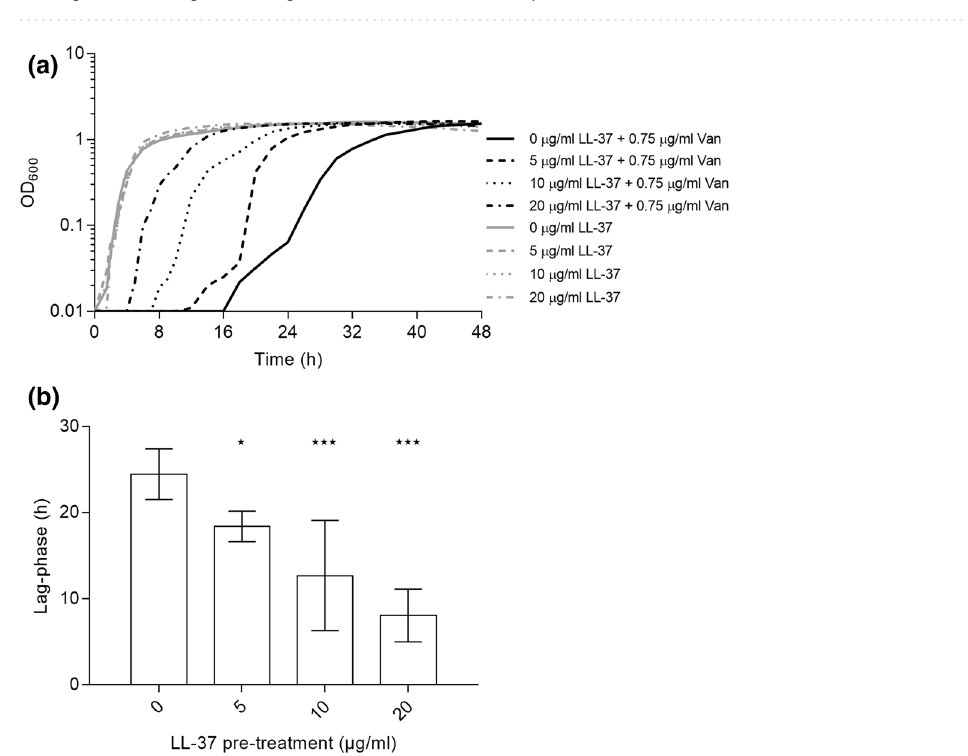
Figure 2. LL-37 influences vancomycin susceptibility of S. aureus in liquid culture. ( a ) The growth of S. aureus FPR3757 with (black lines) or without (grey lines) exposure to 0.75 μg/ml vancomycin after treatment for 1 h with 0, 5, 10 or 20 μg/ml LL-37. The curves are an average of five replicates. ( b ) The lag-phase of the same cultures depicted in ( a ) (n = 5). Error bars display 95% confidence intervals. ** P < 0.01; * P <